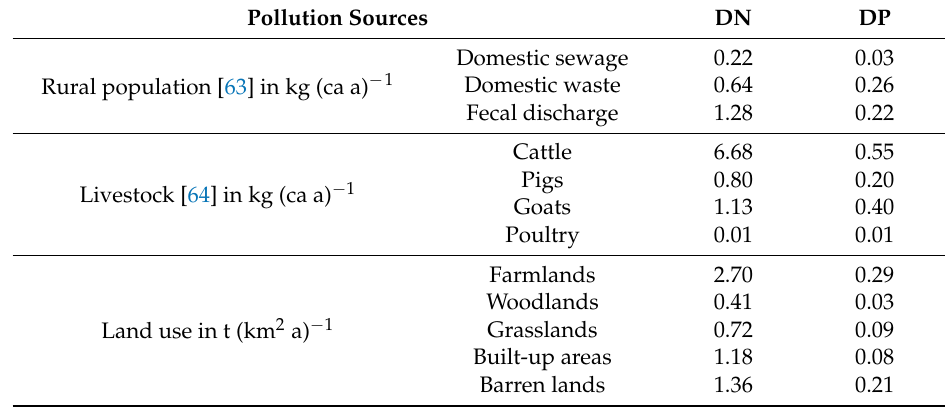
Table 2. Export coefficients for the studied DN and DP pollutant